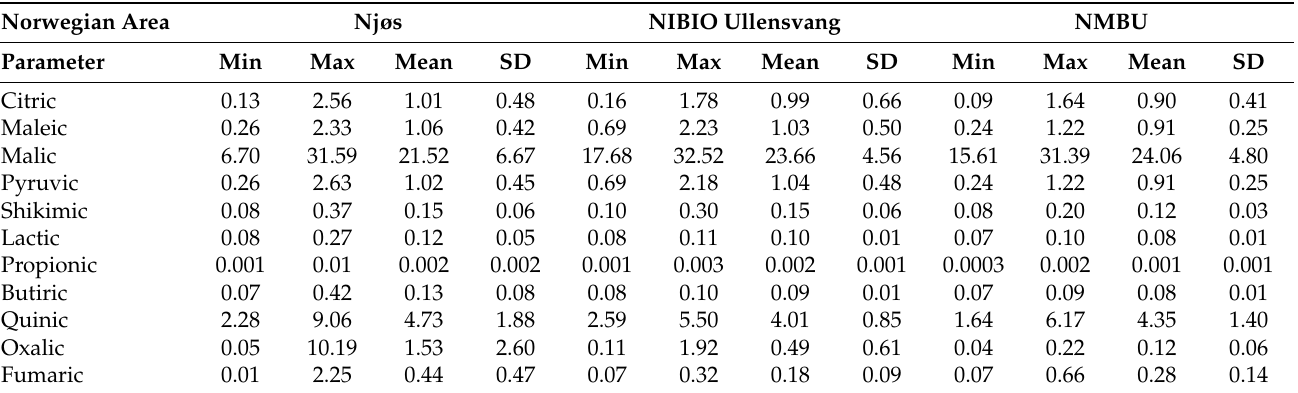
Table 4. Descriptive analysis of organic acids content (g/kg dw) in 68 Norwegian plum cultivars from Njøs (42 samples) and NIBIO Ullensvang (8 samples) collected in 2019 and 2021, and from NMBU (18 samples) collected in 2019 and